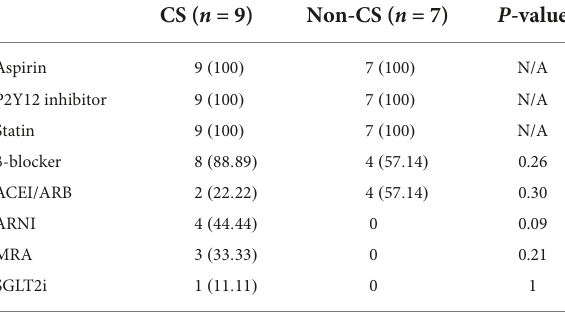
TABLE 5 Comparisons of the medical therapy between patients with- and without CS who had repeat imaging.